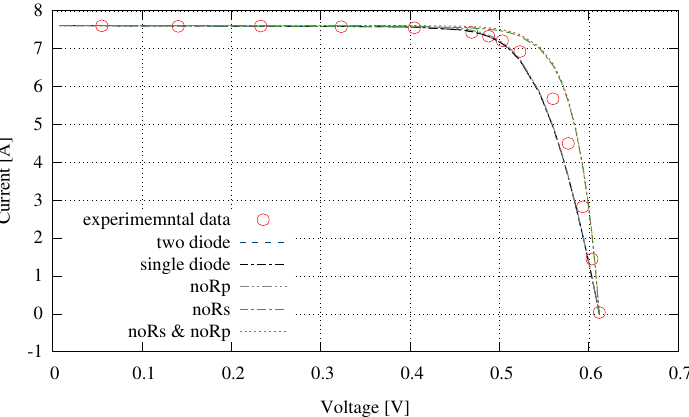
Figure 4. Results of model tuning for Q.CELLS Q6ML-1600 PV